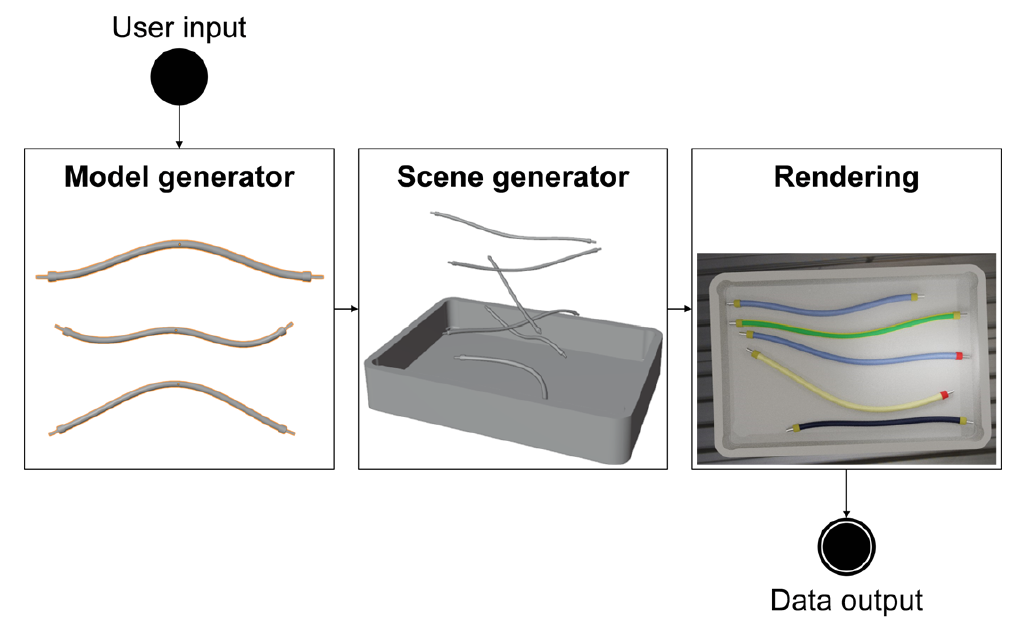
Figure 1. Illustration of the three-step automatic data-generation pipeline for